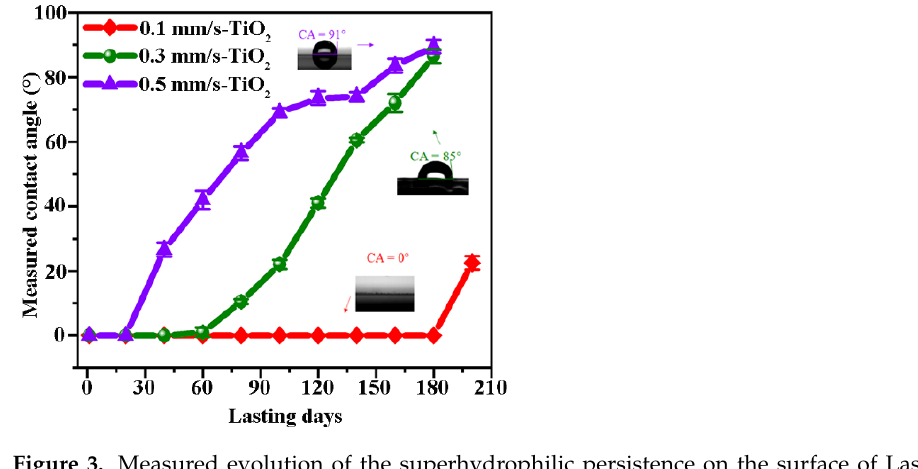
characteristic peak at 2 θ = 25.4° (corresponding to a <101> crystal plane of the anatase),